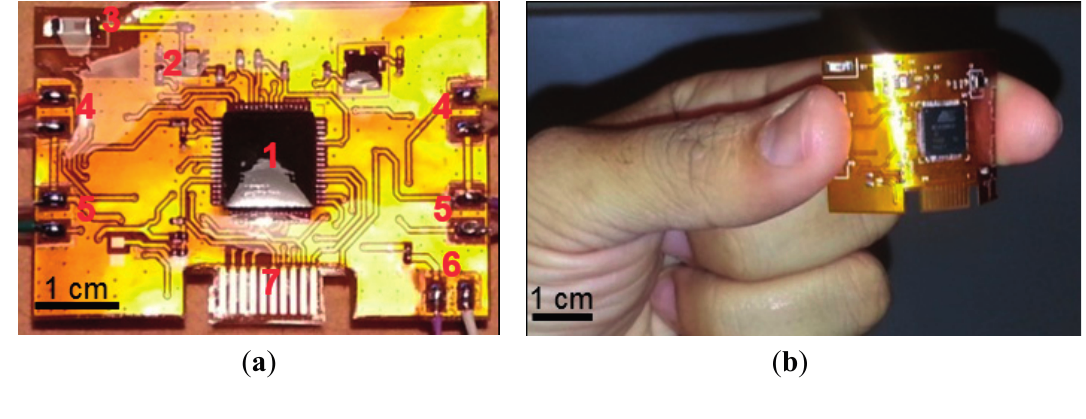
Figure 1. ( a ) The improved wound sensing system with its various parts annotated as (1) RF transmitter, (2) RF balun, (3) Antenna, (4) Interface for moisture sensor, (5) Interface for pressure sensor, (6) Interface for battery, and (7) Chip programming interface. The sensing system is coated with a layer of biocompatible material polydimethylsiloxane (PDMS); ( b ) the flexible telemetric sensing system shown without sensors; ( c ) the complete wound sensing system with all the sensors